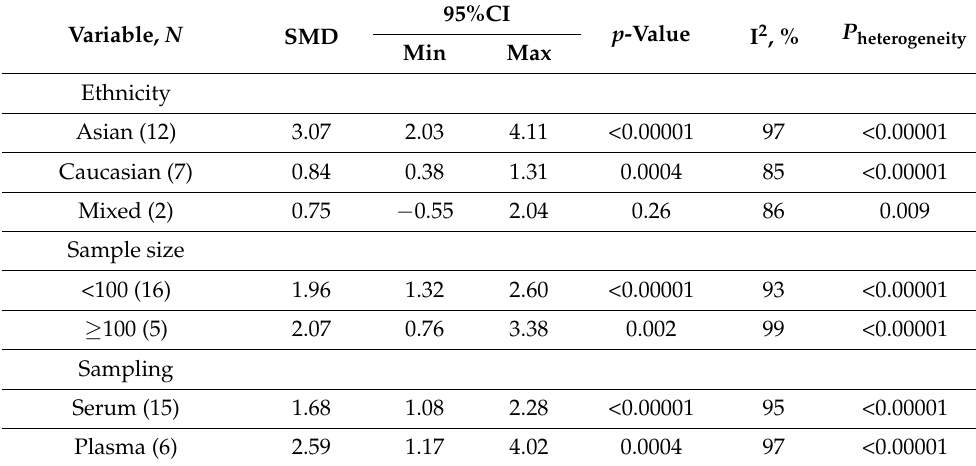
Table 4. Subgroup analysis. Intercellular adhesion molecule-1 levels in adults with obstructive sleep apnea compared to